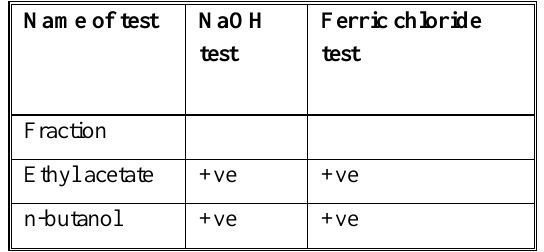
Table 3. Qualitative analysis of